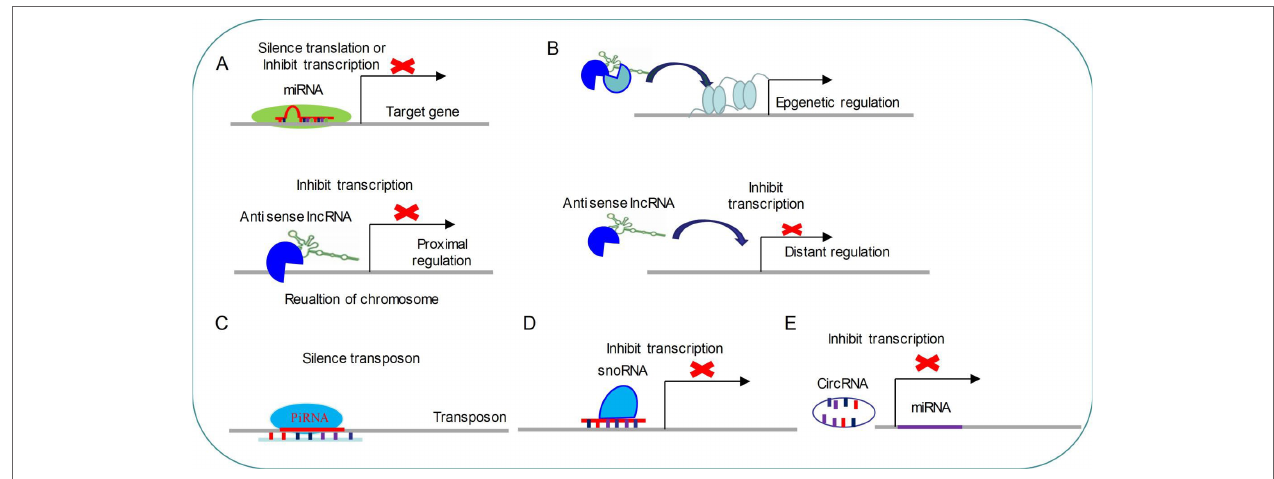
FIGURE 1 | Common regulatory mechanism of non-coding RNAs (A) miRNAs modulate target genes by silencing mRNA translation or inhibiting mRNA transcription. (B) LncRNAs regulate gene transcription by three distinct ways. (C) PiRNAs target transposon for silencing its expression. (D) SnoRNAs inhibit transcription by targeting specific loci. (E) CircRNAs are able to repress miRNA expressions.